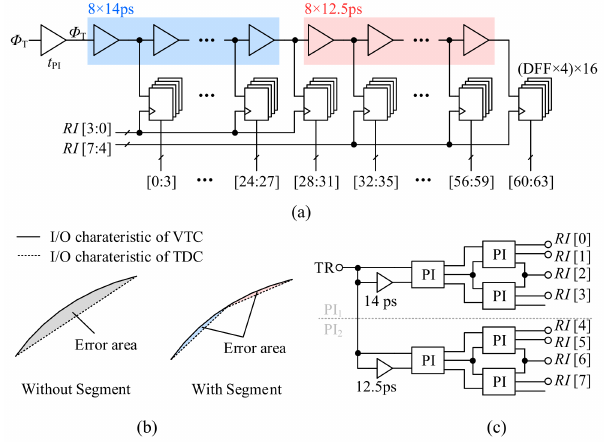
Figure 6. ( a ) Segment TDC. ( b ) Conversion characteristic of the VTC. ( c ) circuit of the phase interpo- lation.